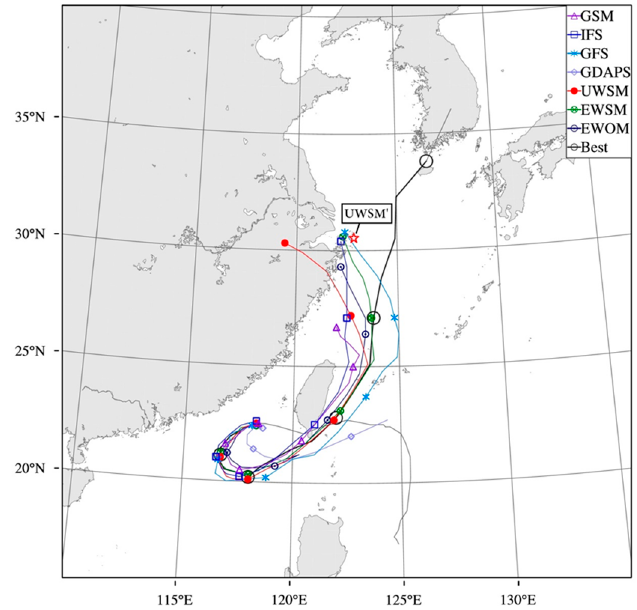
Figure 4. Best track (black line) and track forecast for Tembin (1214) at 0000 UTC 25 August 2012. Markers of each line indicate locations every 24 h. UWSM’ (a star shape marker) was produced by using training datasets during 2011–2012 except for this case.